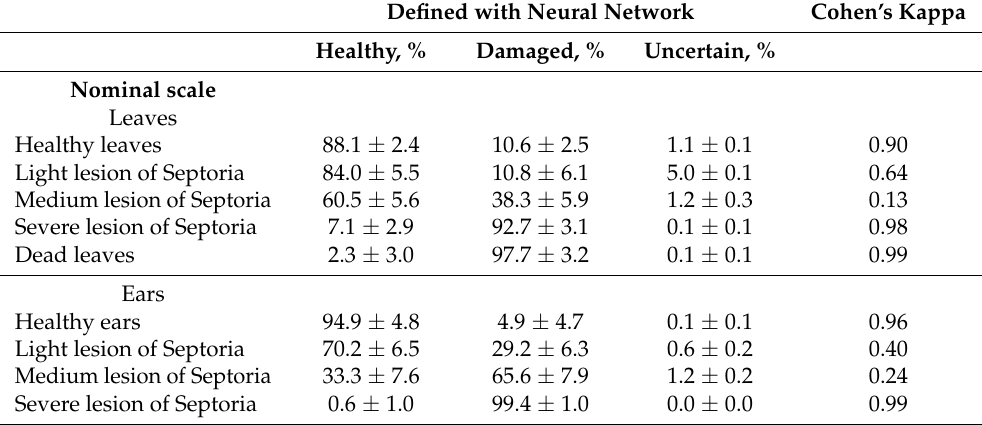
Table 1. Checking the results of the neural network determining the septoriosis diseases of wheat leaves and ears: the average value of the feature definition in % with a confidence interval of the average (detection